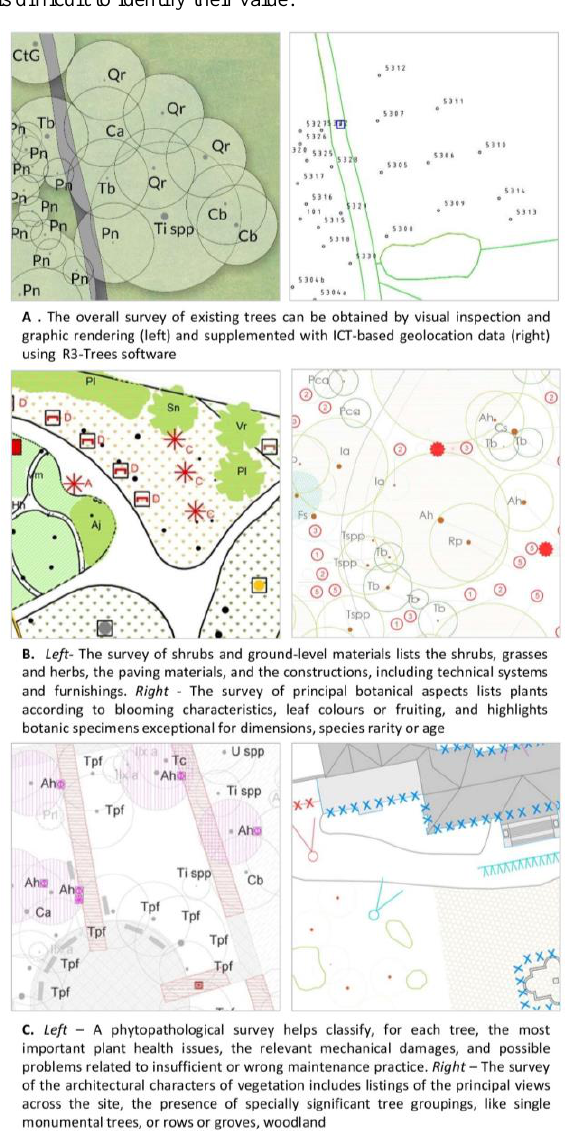
Figure 4. Extracts from thematic surveys of Villa Cusani Traversi Tittoni historic garden in Desio (Monza and Brianza